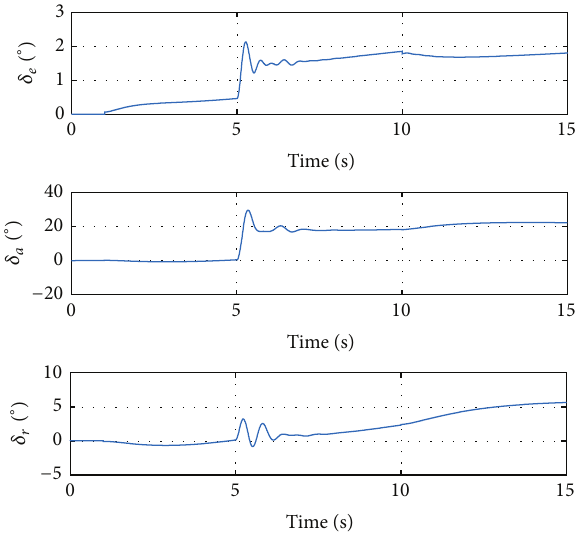
Figure 4: Control surface deflections in simulation with step input